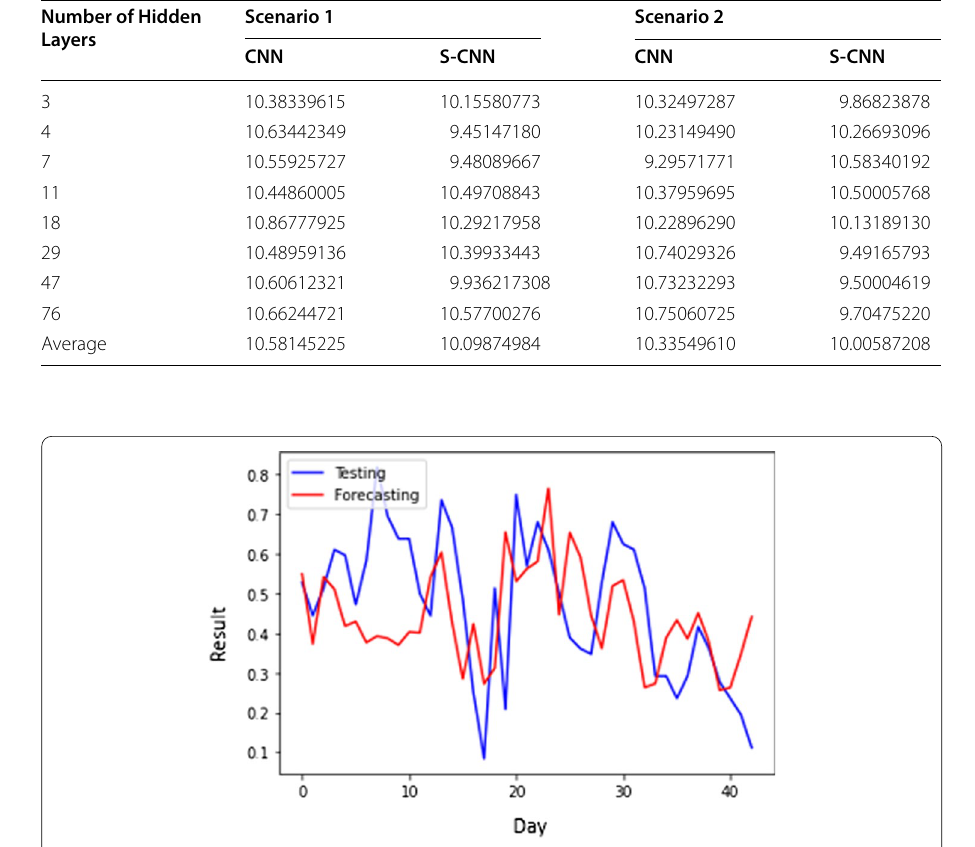
Table 7 MAPE of CNN and S-CNN ( α Number of Hidden Layers